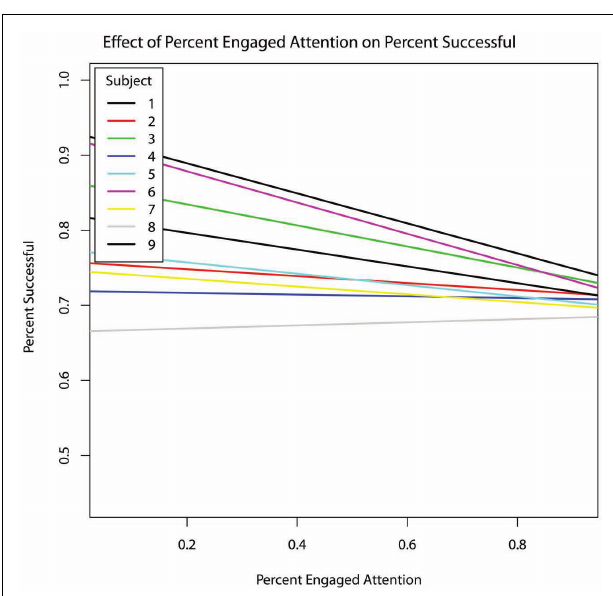
time during which the therapist provided proximal prompt- ing was negatively related to choice complexity ( b = − 16.73, p = 0.0193). No other type of therapist prompting